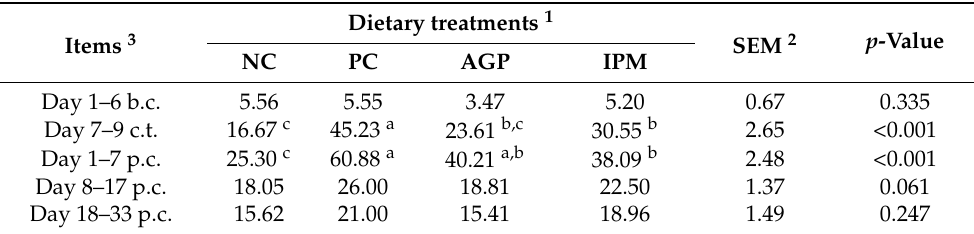
Table 3. Effect of dietary treatments on the post-weaning diarrhea incidence of weaned pigs chal- lenged with E. coli K88